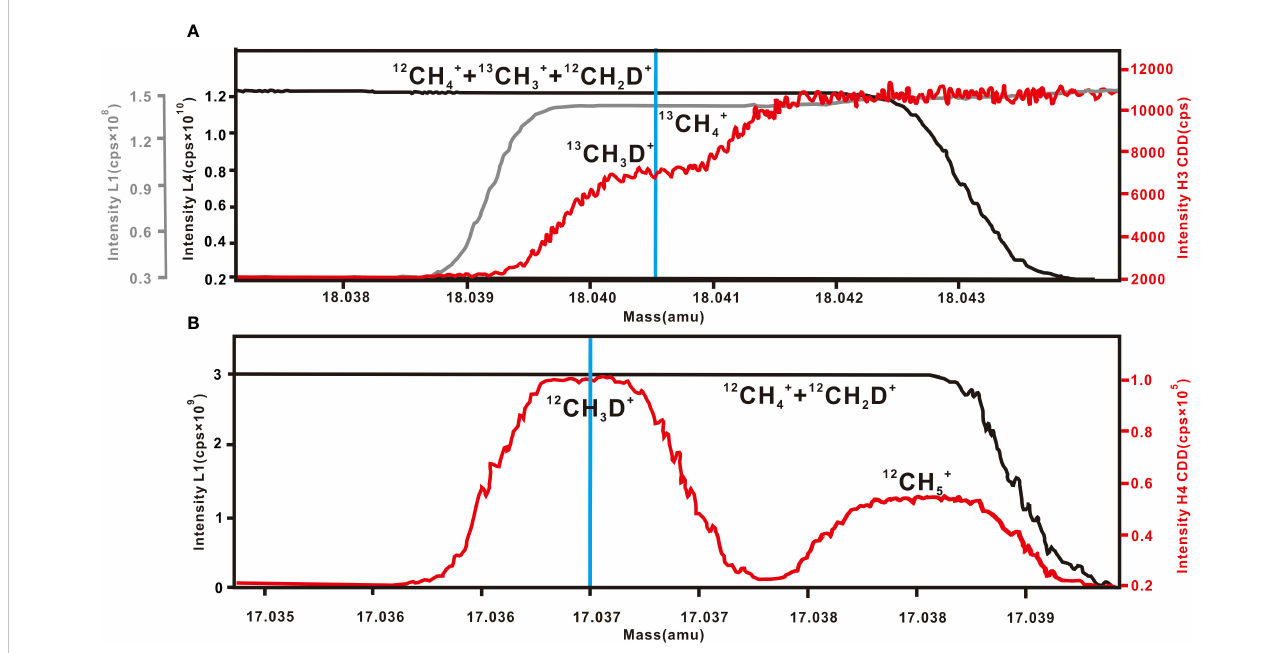
FIGURE 2 Mass scan for (A) 12 CH + 4 + 13 CH + 3 + 12 CH 2 D + , 13 CH + 4 , and 13 CH 3 D + and (B) 12 CH + 4 + 12 CH 2 D + and 12 CH 3 D + . Blue line represents the analytical position for the targeted isotopologue. (cps = counts per